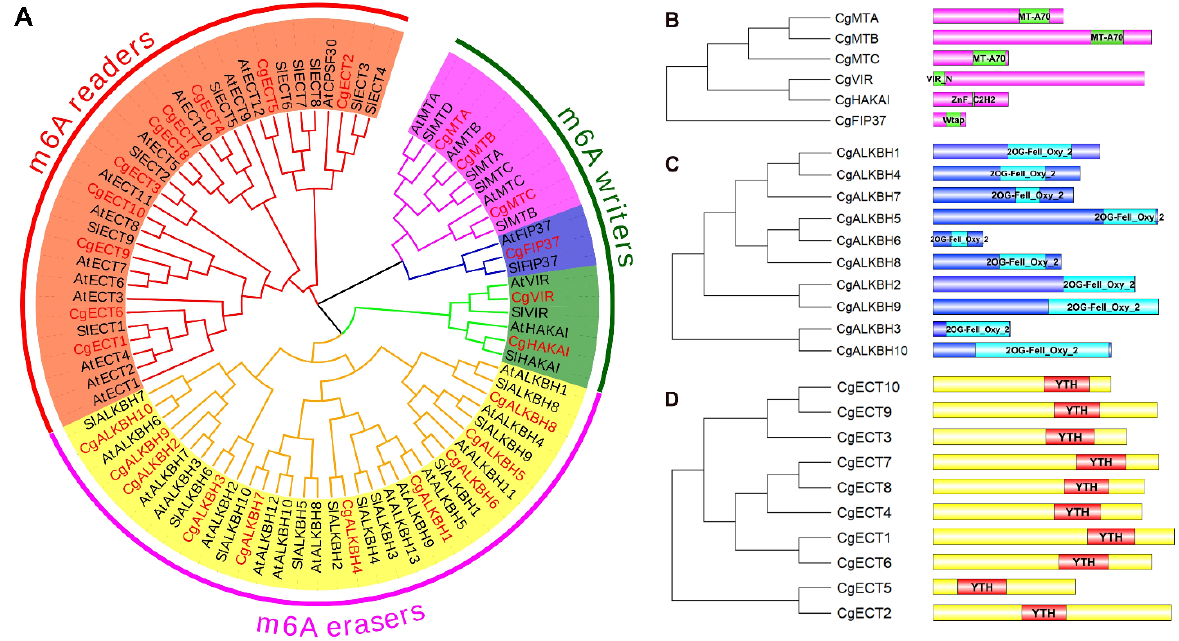
Figure 2. Phylogenetic relationship of the m 6 A regulatory genes from C. grandis , S. lycopersicum , and A. thaliana . ( A ) Phylogenetic relationship of m 6 A regulatory genes from C. grandis , S. lycopersicum , and A. thaliana . ( B ) MT-A70, VIR-N, ZnF-C2H2, and WTAP conserved domains of m 6 A writer groups (Pink represents’ MTs; Blue represents’ FIP37s; Green represents’ VIRs and HAKAIs). ( C ) One highly conserved 2OG-Fell-Oxy-2 domain of m 6 A eraser groups (Yellow represents’ ALKBHs). ( D ) YTH conserved domain of m 6 A reader groups (Orange represents’ ECTs).